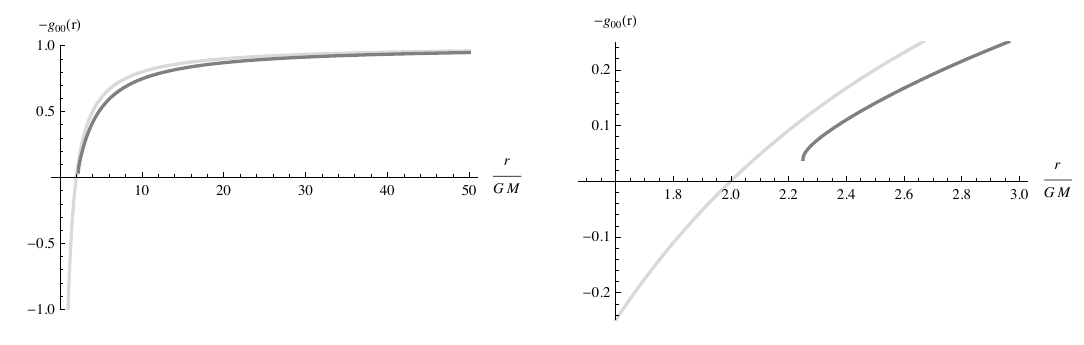
Figure 1 . Comparison of the g 00 ( r ) component of the metric for black holes in minimal massive gravity (dark gray) and Schwarzschild black holes (light